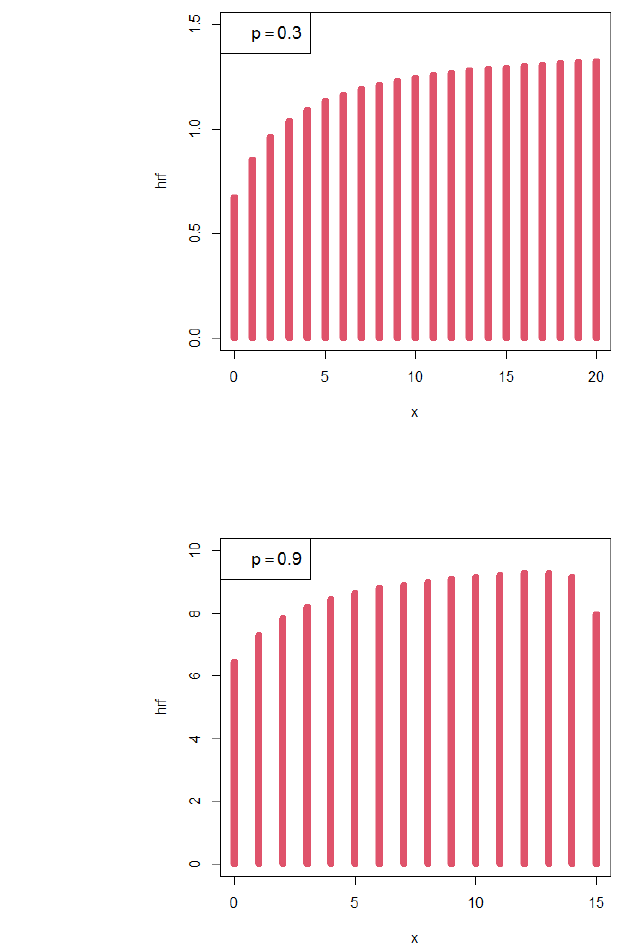
Figure 3. Plots of hazard rate of BNDL distribution for some choices of p .